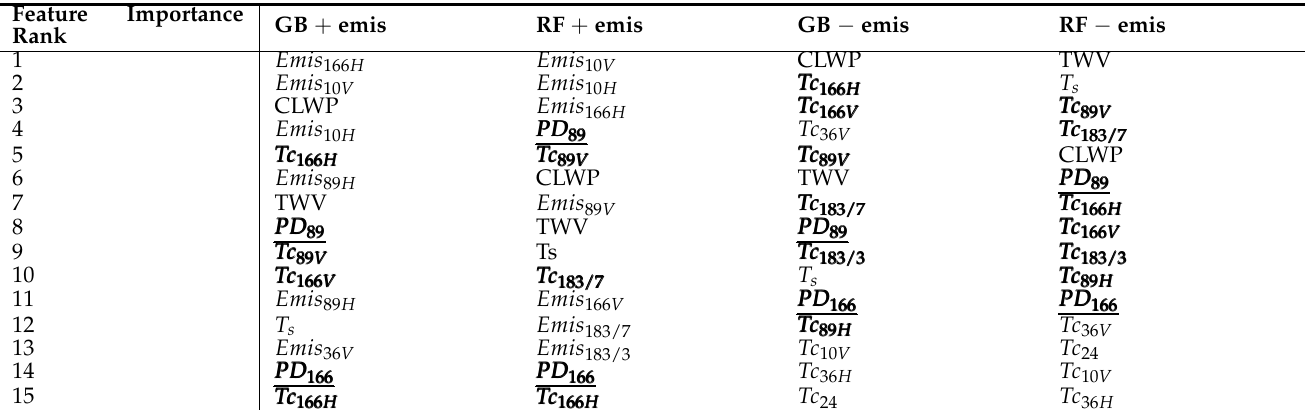
Table 4. First 15 most important features listed for the GB and RF models with ( + emis) and without ( − emis) emissivity in the training process. High-frequency channels T c s are highlighted by bold letters, and PD s are further